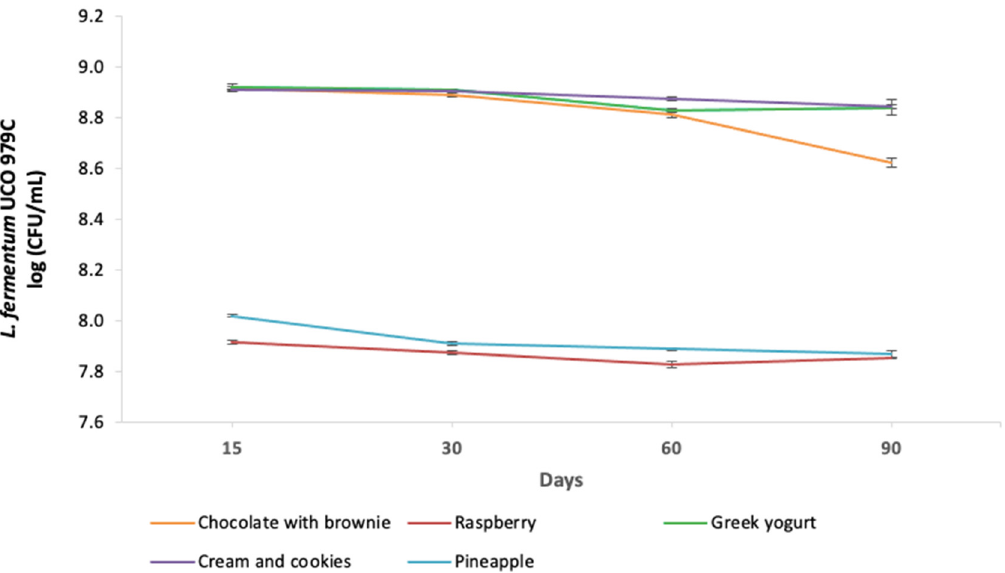
Figure 1. Viability of the probiotic L. fermentum UCO-979C strain in different ice cream bases during 90 days of storage at − 18: day 15 (T0), the time of storage of the ice creams by the manufacturer and the day they were delivered to the laboratory; day 30 (T1); day 60 (T2); and day 90 (T3). Table 1. Viability of the probiotic strain L. fermentum UCO-979C in the different ice cream bases after 90 days of storage at − 18 ◦